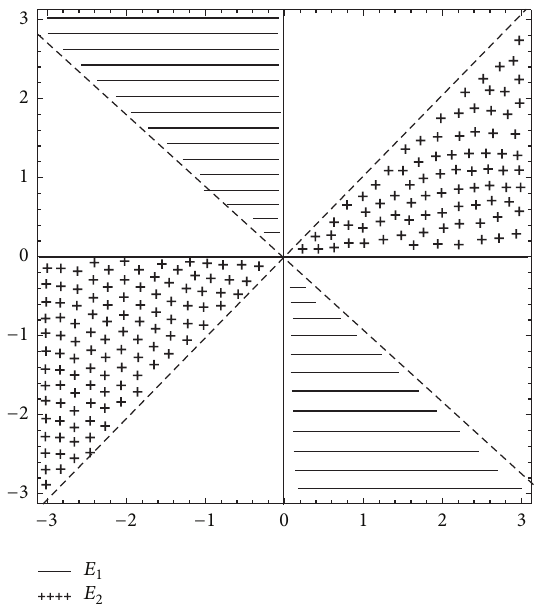
Figure 1: The sets 𝐸 1 and 𝐸 2 and the rays {𝑥 ∈ R 2 : 𝐺 𝑖 (𝑥) = 0}